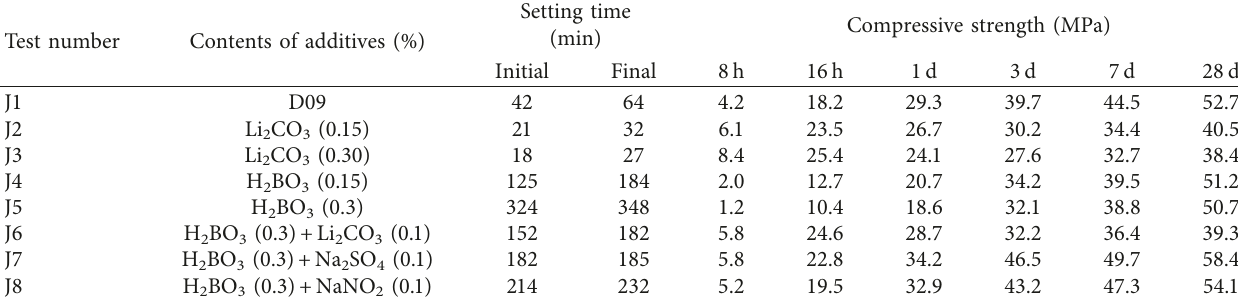
Table 7: Effects of additives on performances of composite cementing